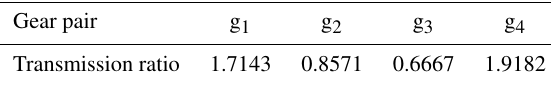
Table 2. Transmission ratio of each gear pair. Gear pair g 1 g 2 g 3 g 4 Transmission ratio